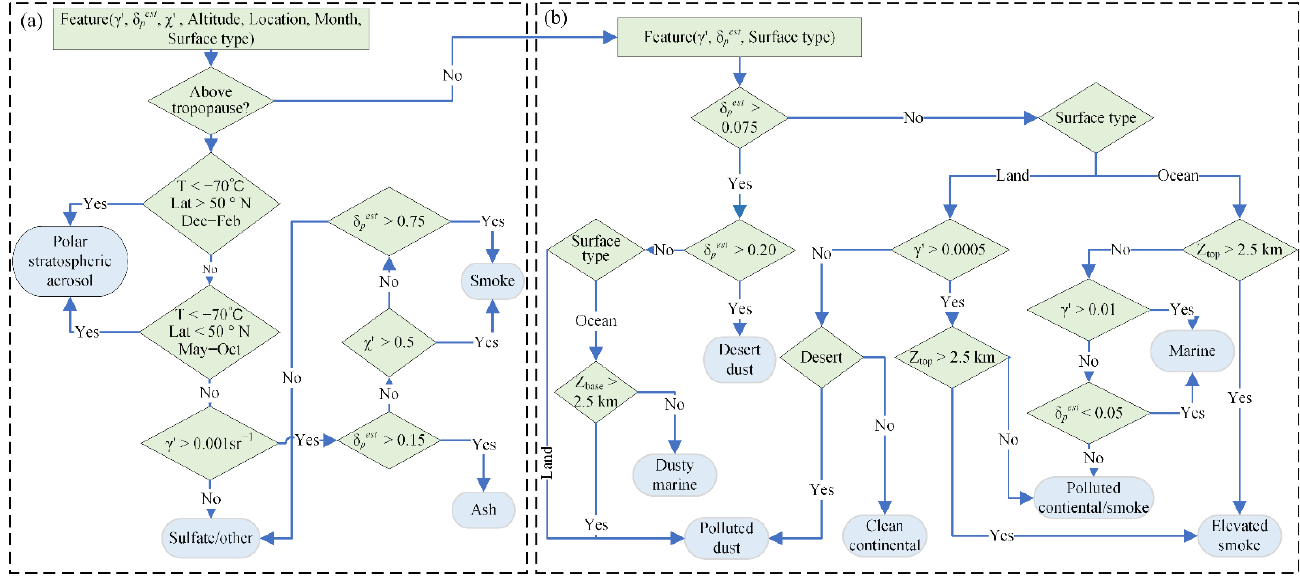
Figure 2. Flowchart of the aerosol subtypes selection scheme for ( a ) stratospheric aerosols and ( b ) tropospheric aerosols (Modified from Kim et al. [48] ).